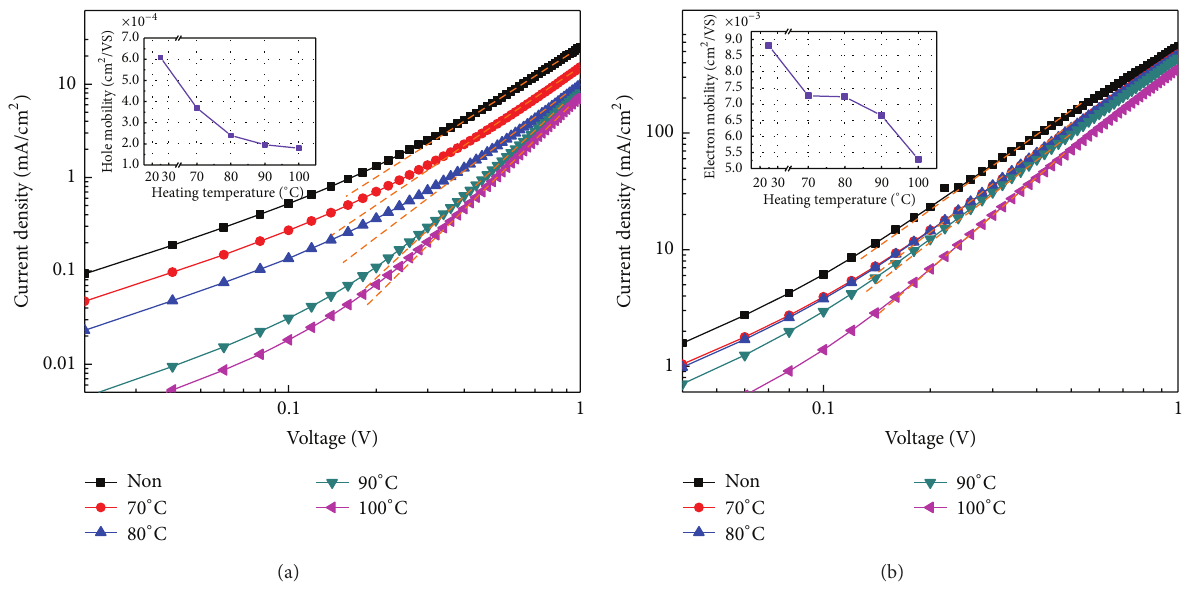
Figure 5: The dark J-V curves on log-log plots of the (a) hole-only and (b) electron-only OPV devices with the PBDTTT-C:PC 71 BM layers with 3% DIO heated under different temperatures for 5